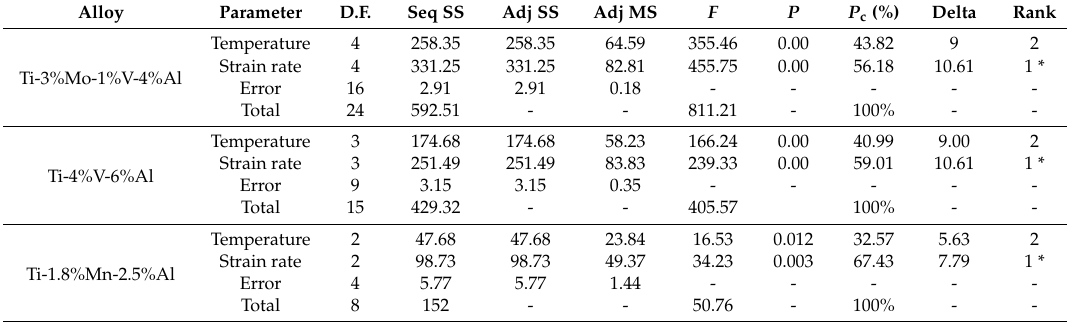
Table 4. Analysis of variance for the S/N ratios of the σ s .